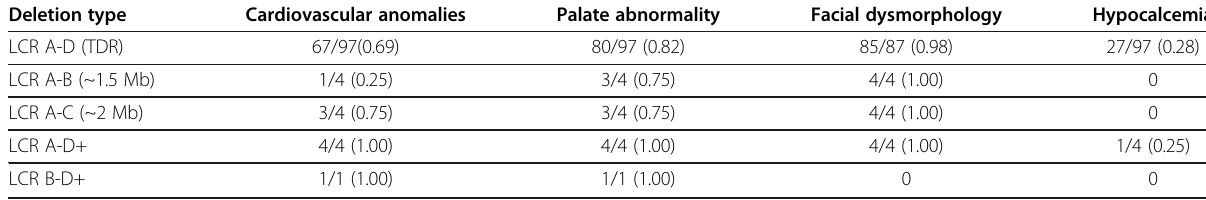
Table 1 Clinical data for 22q11.2DS subjects - Physical features Deletion